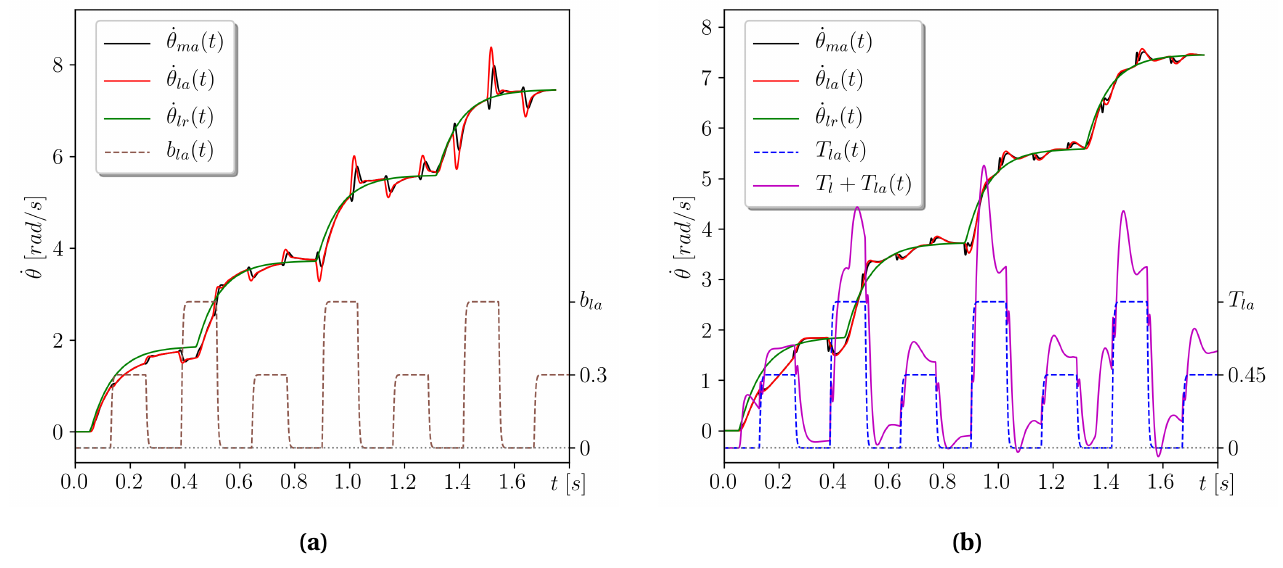
Figure 12. The closed-loop reference model control system response at the presence of b la ( t ) (a) and T la ( t ) (b) and an adaptive PID + PI (high frequency) – see case B in the block diagram in Figure 4.